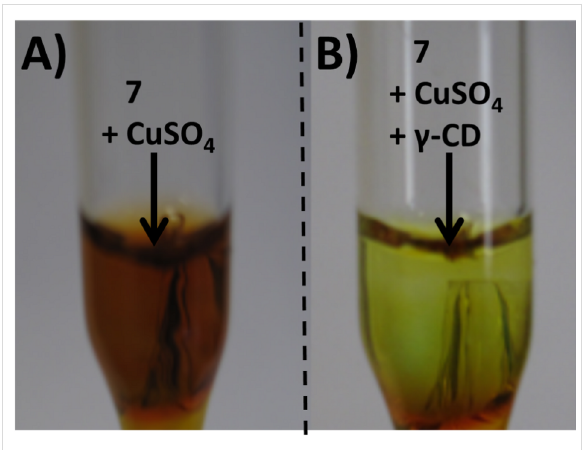
Figure 1: Color-changing effects of polymer 7 upon addition of A) CuSO 4 and B) CuSO 4 and γ -CD in a 50:50 vol % in methanol/water